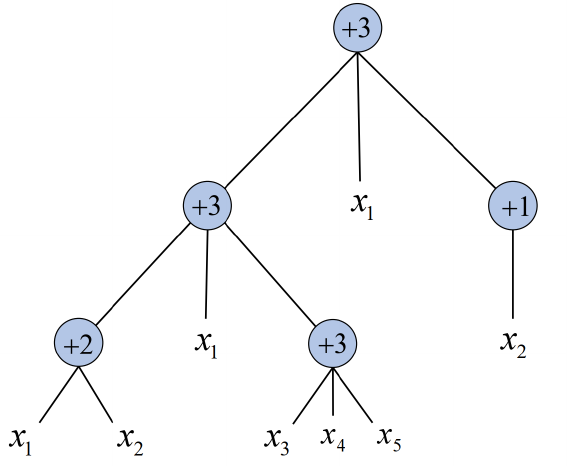
Figure 4. Example diagram of a flexible neural tree structure. Table 1. GP parameter values.